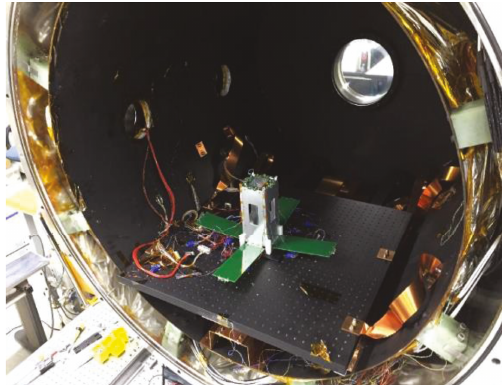
Figure 13: TV test setup after the release function test of the